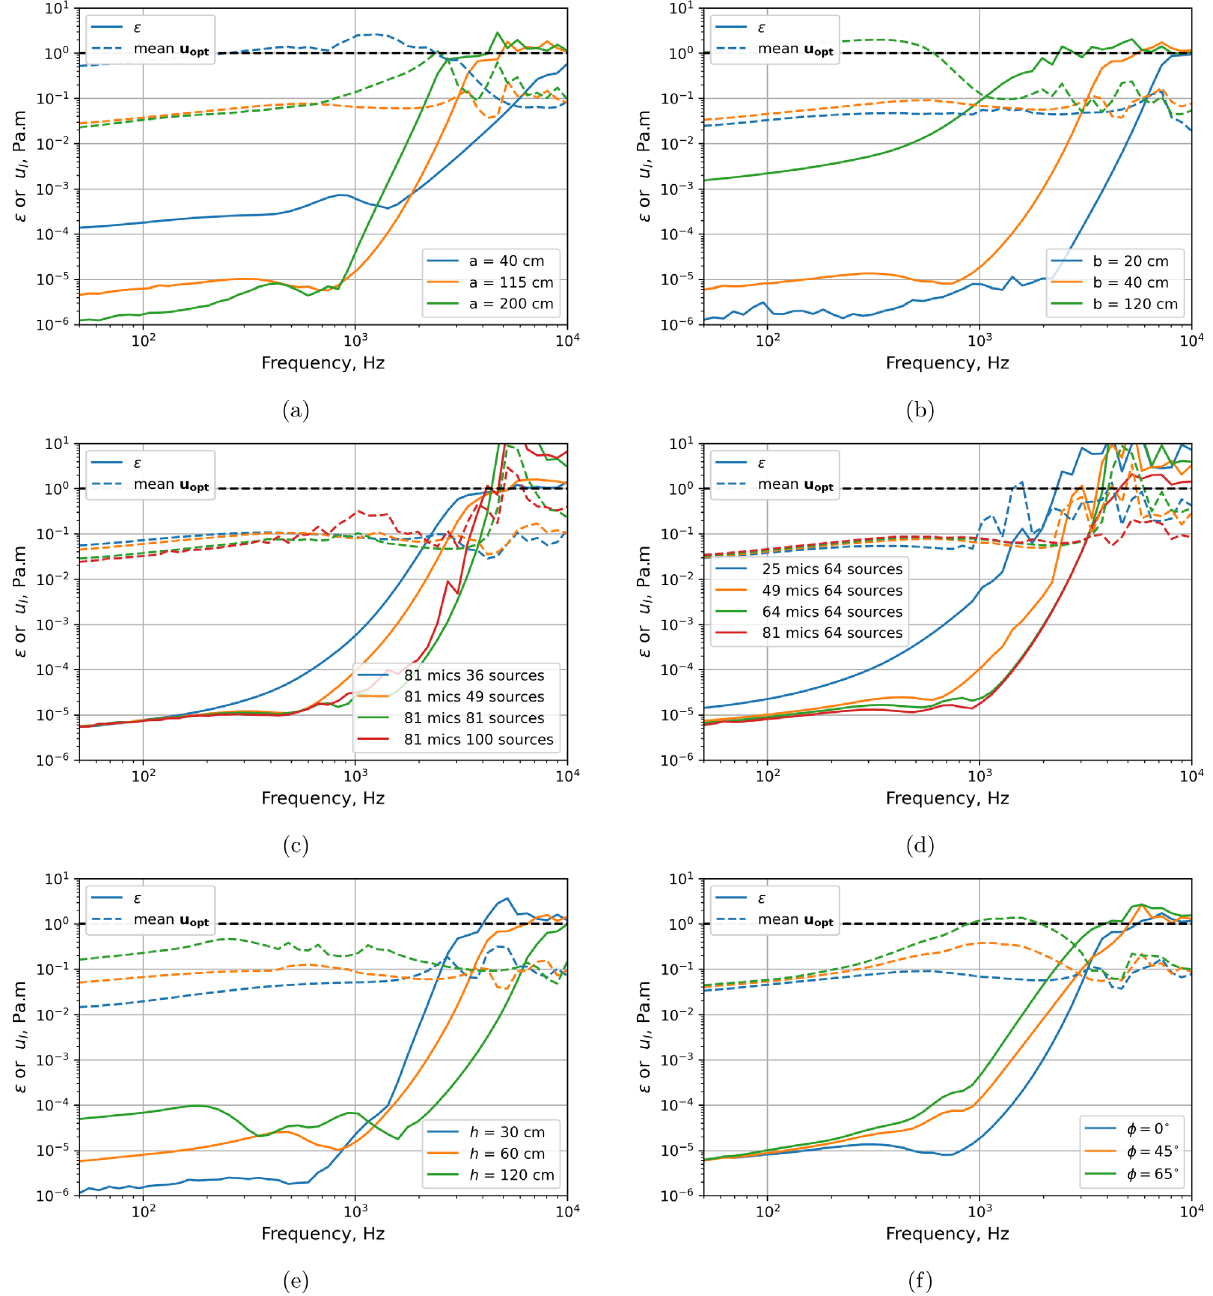
Figure 7. Reproduction error e in the xy plane at z = 0 and mean amplitude u opt of the sources when varying a parameter of the system: Dimension of the source array a (a), Dimension of the microphone array b (b), number of sources D l (c), number of microphones D m (d), height of the loudspeaker array h (e), angle of incidence / (f). The other parameters remain constant and are given in Figure